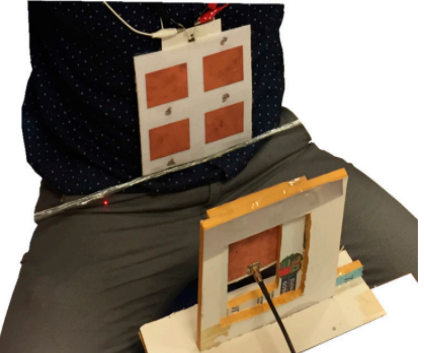
Figure 6. On-body experimental setup of 2 × 2 textile rectenna array